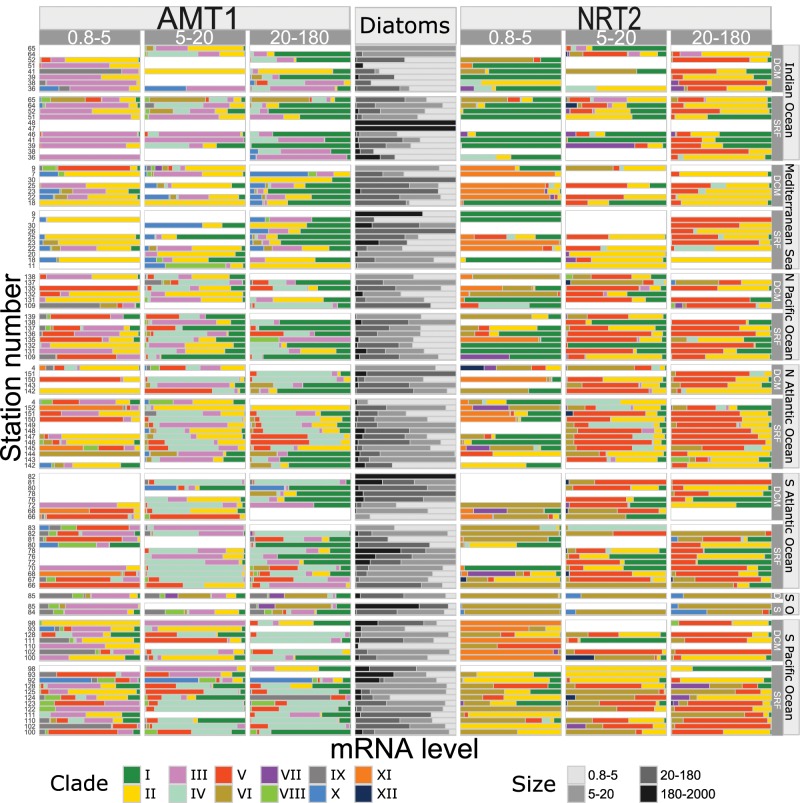
Barplot of clades relative mRNA abundances. DiAMT1 (columns 1–3) and DiNRT2 (columns 5–7) clades are showed as distributed across the three size classes (0.8–5, 5–20, and 20–180 μm). Sampling stations are clustered according to the sampling depth, surface (SRF or S) or deep chlorophyll maximum (DCM or D), and oceanic basin (where SO equals to Southern Ocean). In the center column the barplot of relative mRNA abundances of transcripts annotated as diatoms in the different size fractions of the metatranscriptome.